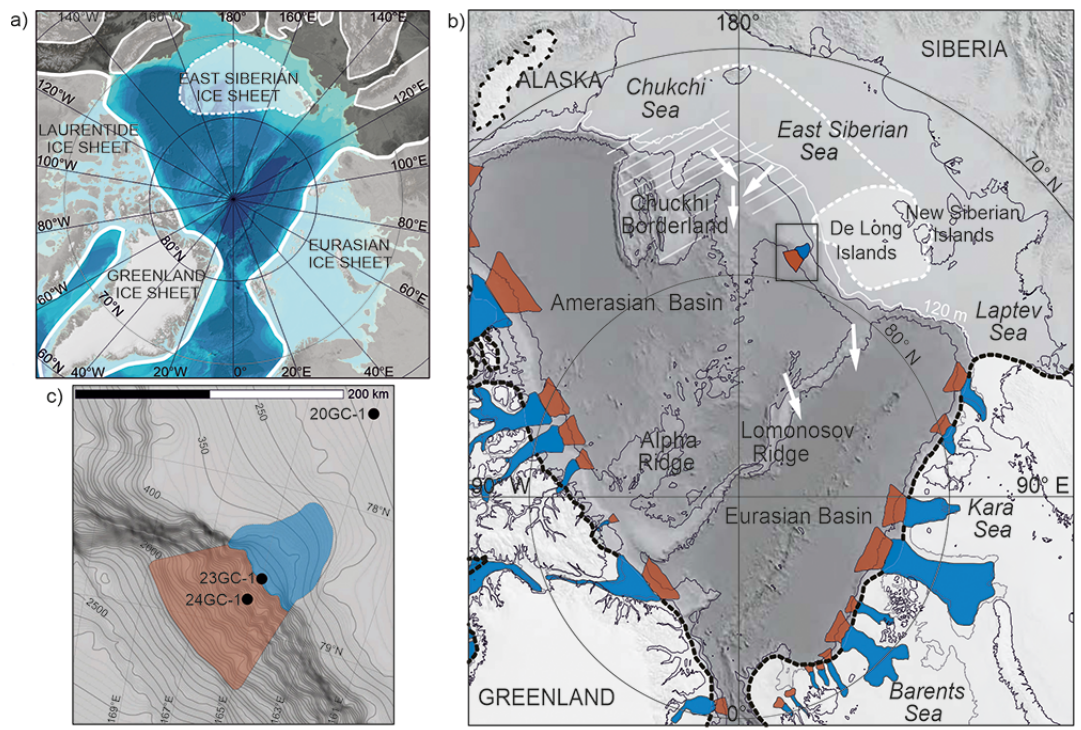
Figure 1. (a) Quaternary ice sheets in the Arctic according to Jakobsson et al. (2010). Proposed maximum extent of the East Siberian Ice Sheet (MIS 6), and LGM ice in Siberia and Alaska redrawn from Niessen et al. (2013). Base map from the International Bathymetric Chart of the Arctic Ocean (IBCAO) by Jakobsson et al. (2012). (b) The extent of Quaternary glaciations in the Arctic region is shown by dashed black and white lines according to Jakobsson et al. (2014). The possible extent of exposed land during the global eustatic low stand of the LGM is highlighted with the 120m isobath across the Chukchi and East Siberian seas (O’Regan et al., 2017). White arrows indicate the direction of ice flow by Jakobsson et al. (2016) and glacial extent around the De Long Islands redrawn from Basilyan et al. (2008), respectively. Glacially excavated cross-shelf troughs (blue) and trough mouth fans (brown) are according to Batchelor and Dowdeswell (2014), and the single trough (De Long Trough) on the East Siberian shelf by O’Regan et al. (2017). The black rectangle marks the location of the map shown in (c) . Original figure by O’Regan et al. (2017). (c) Inset figure showing the locations of studied cores 20-GC1, 23-GC1, and 24-GC1, while the brown and blue areas illustrate the constraints of the De Long glacial trough and trough mouth fan deposits (O’Regan et al., 2017). Original figure by O’Regan et al.